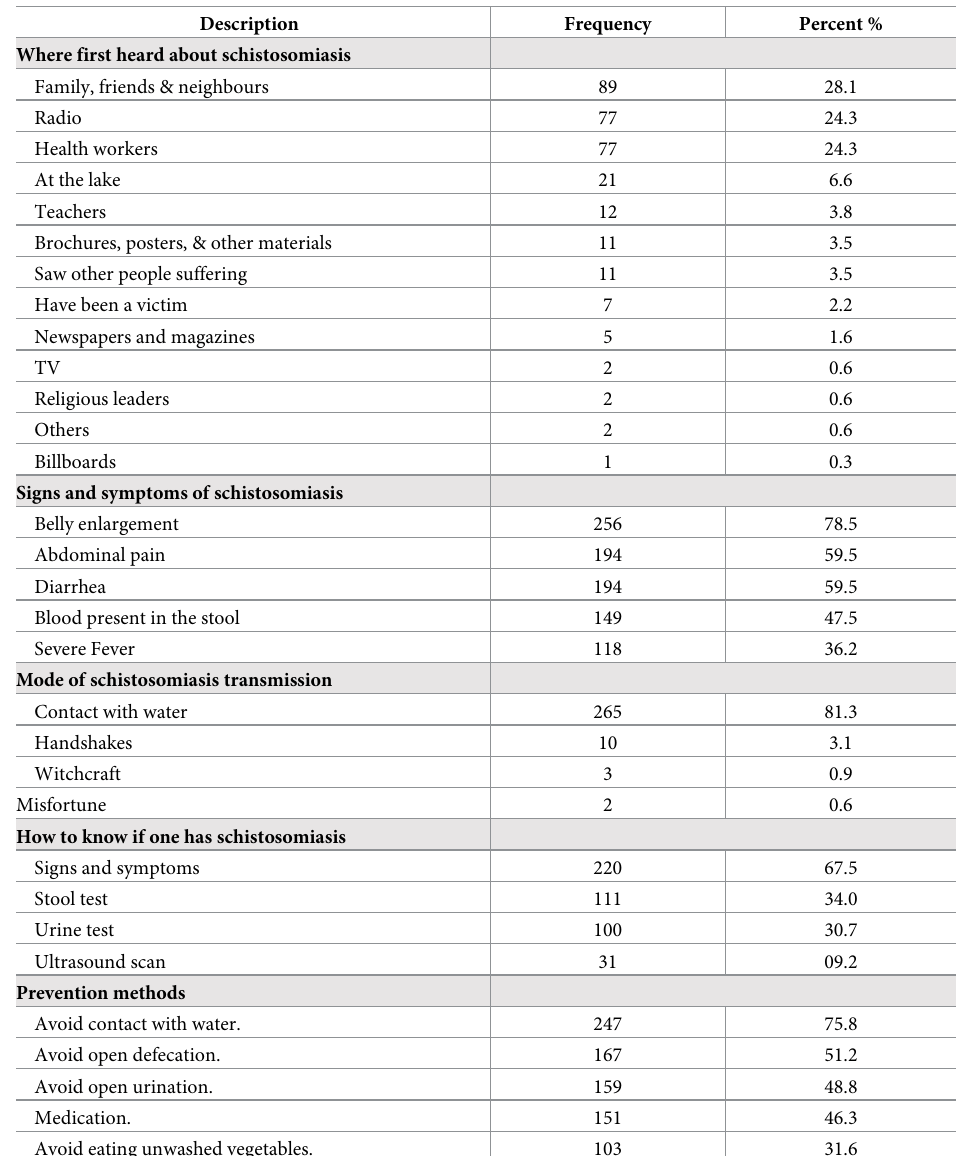
Table 2. Respondents’ knowledge of